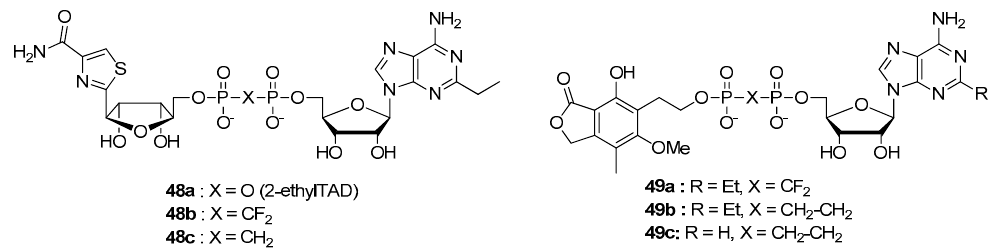
Figure 11. Potent inhibitors of IMPDH and K562 cell proliferation obtained by pyrophosphate linkage modification in TAD and MAD analogs [69].